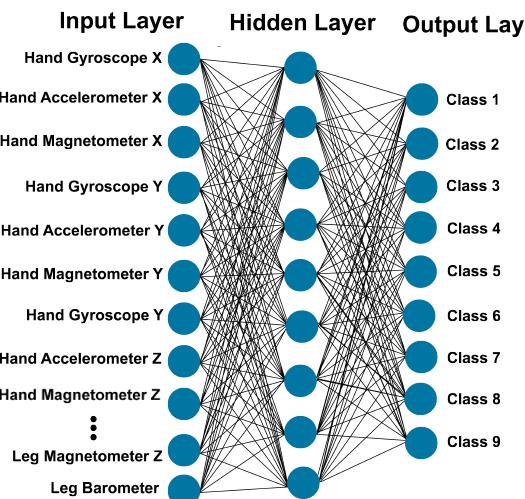
Figure 6. Example of applied neural network with 9 neurons at the hidden